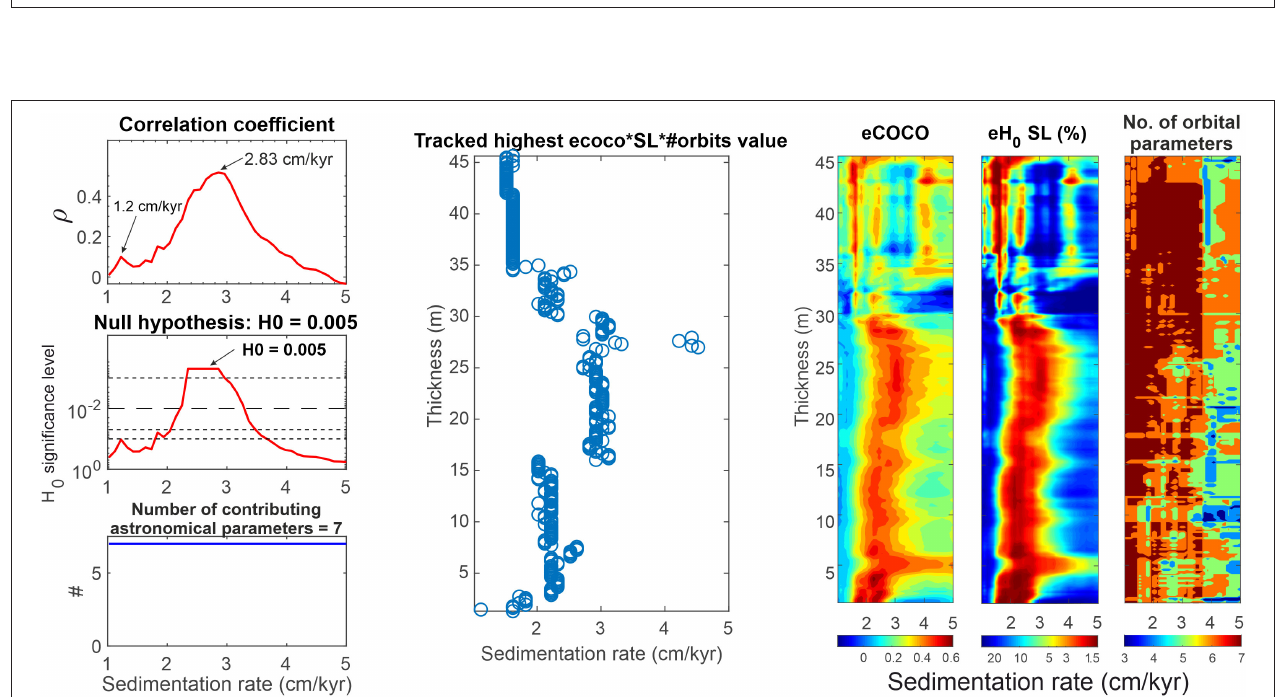
FIGURE 7 | Tracking the sediment accumulation rate along the studied section. The COCO analysis indicates a mean SAR of 2.83 cm/kyr and the eCOCO analyses of the MS series. For both the COCO and eCOCO, tested sedimentation rates range from 1 to 5 cm/kyr with a step of 0.1 cm/kyr, and the number of Monte Carlo simulations is 5,000. For eCOCO analysis, the sliding window size is 15m; the sliding window step is 0.078m. In the top-left graphs (Null Hypothesis): the dashed horizontal line indicates H0 = 0.01; the horizontal dotted lines, from top to bottom, indicate H0 = 0.005, 0.05, and 0.1. The top-right graphs are (respectively from left to right) the evolutionary ρ shown with SAR variations; the evolutionary H0 (Null Hypothesis) shown with SAR variations and the evolution of the number of contributing astronomical parameters.